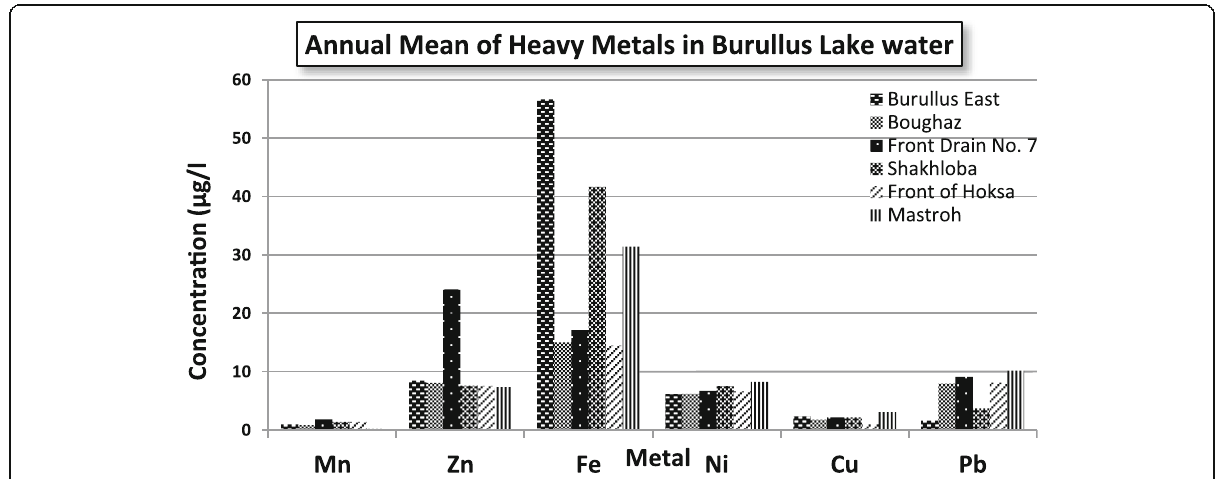
Fig. 2 Annual mean of heavy metal concentration ( μ g/L) in water at each selected site of Burullus Lake during